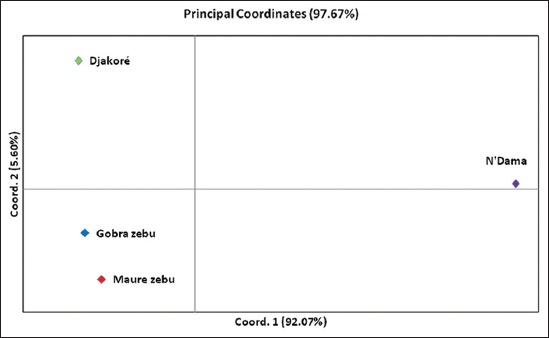
Diagram of principal coordinates analysis based on covariance matrix of Nei’s unbiased genetic distance.